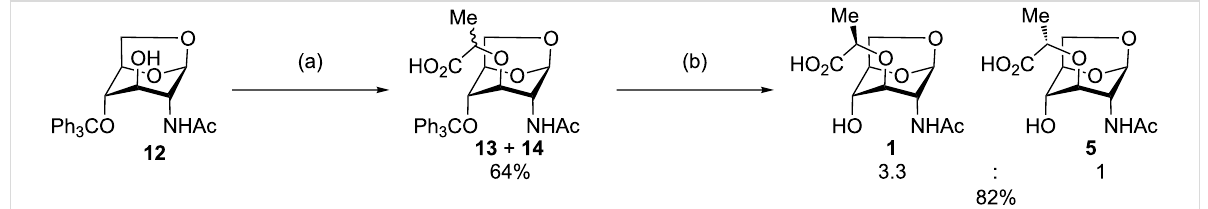
Scheme 3: Synthesis of AnhydroMurNAc and diastereomer 5 . Conditions: (a) (±)-2-chloropropionic acid, NaH, dioxane, 45 °C to 90 °C, 3 h; (b) tri- fluoroacetic acid, CHCl 3 , 0 °C to rt, 3 h.